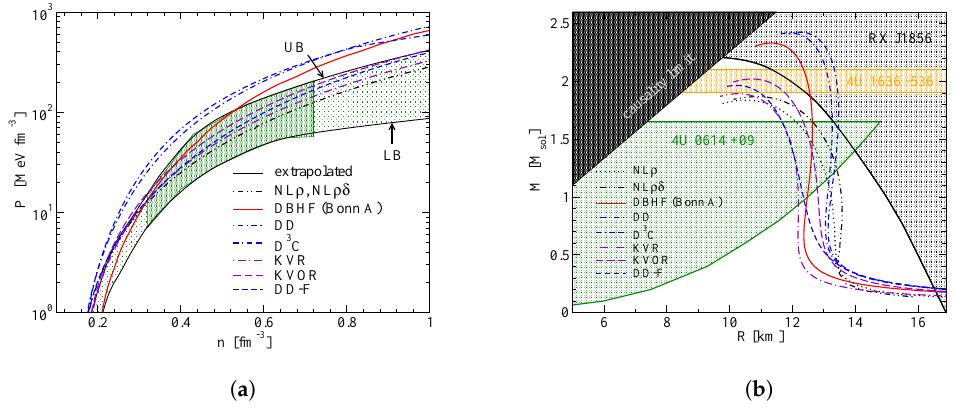
Figure 1. Figure is taken from [1]. ( a ) pressure region consistent with experimental flow data in ISM (dark shaded region). The light shaded region extrapolates this region to higher densities within an upper (UB) and lower (LB) borders; ( b ) mass–radius constraints from thermal radiation of the isolated neutron star RX J1856.5-3754 (grey hatched region) and from quasi-periodic oscillations (QPOs) in the Low-Mass X-Ray Binary (LMXB) 4U 0614+09 (green hatched area). The constraint from 4U 1636-536 (orange hatched region) 2.0 0.1 M was withdrawn and should be replaced by a similar constraint ± (cid:12) 2.01 0.04 M obtained later in [4] for PSR ± (cid:12)